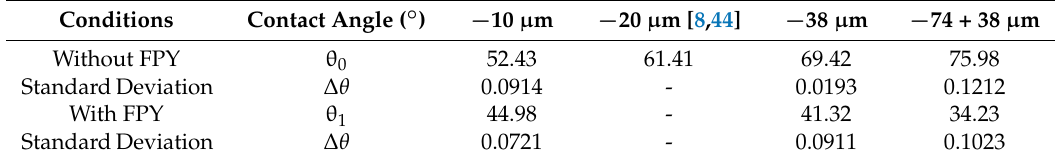
Table 5. Advancing contact angle measurement on talc in the presence and absence of FPY.